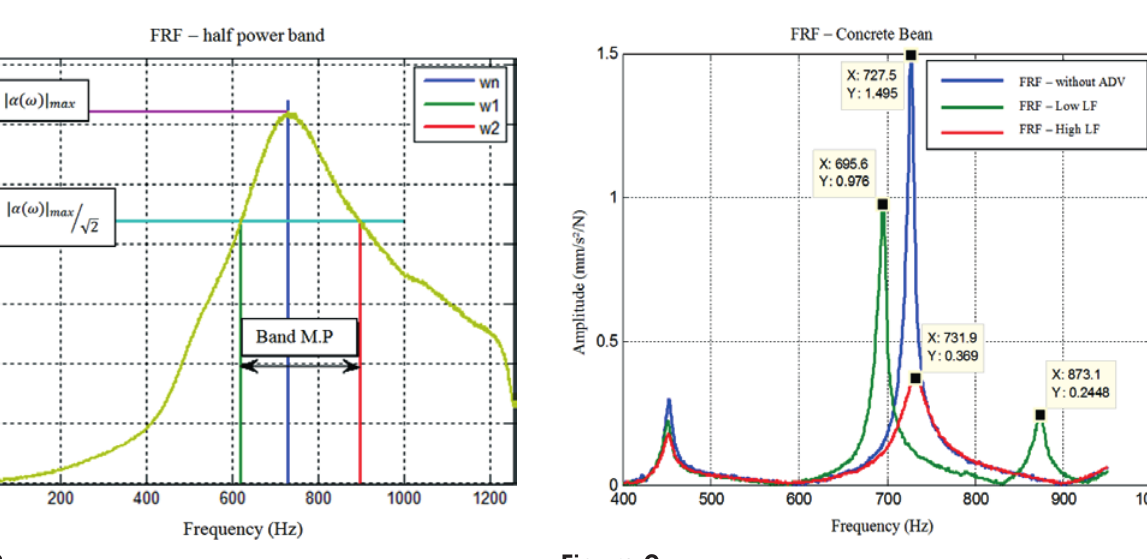
Determination of the loss factor through the half power band method (M.P.)